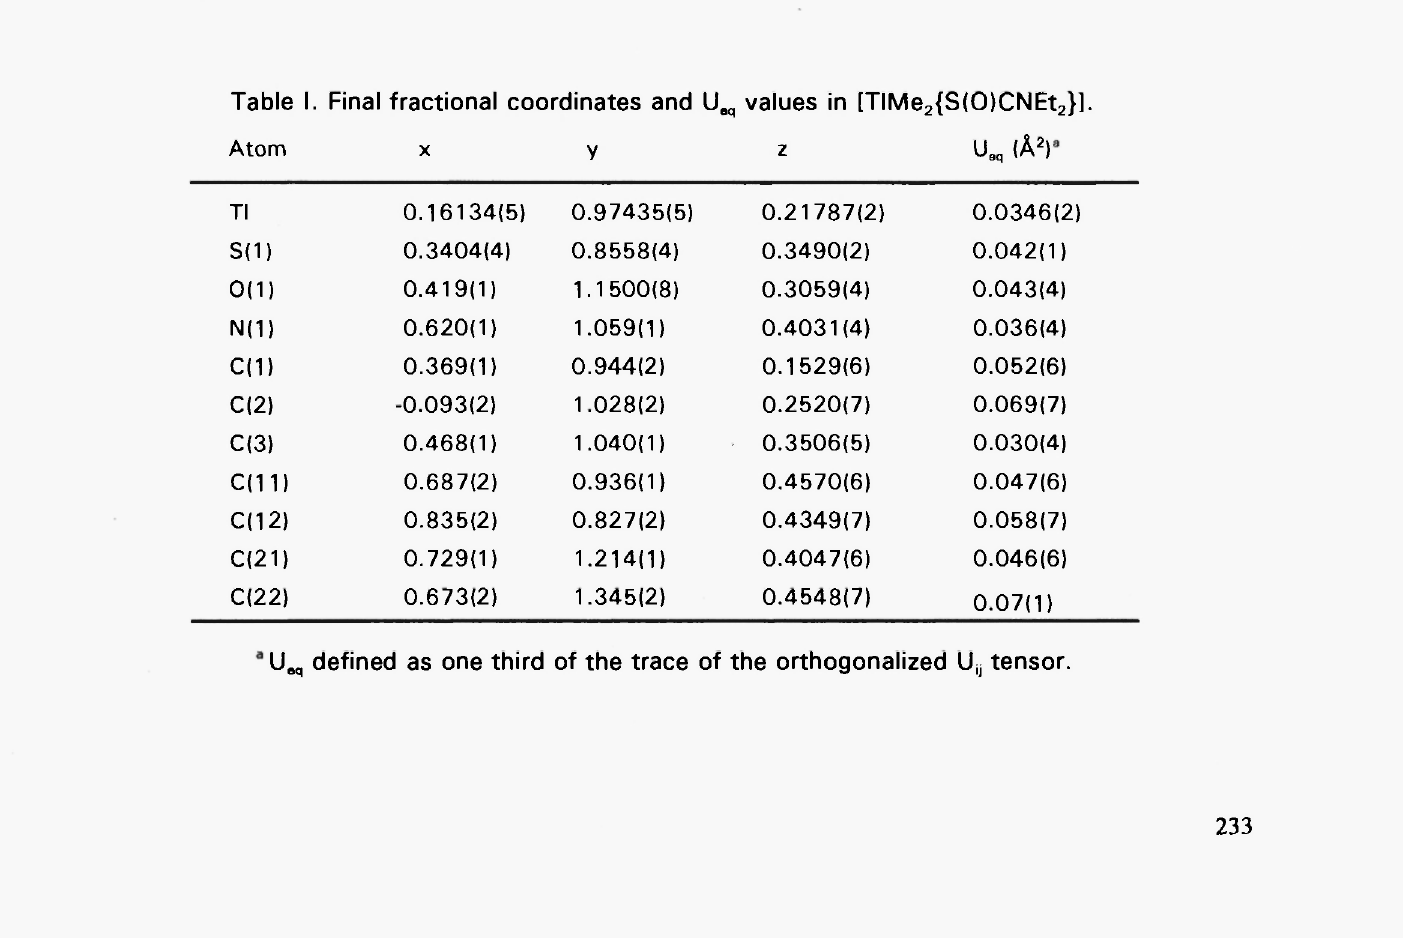
Table I. Final fractional coordinates and U eq values in [TIMe 2 {S(0)CNEt 2